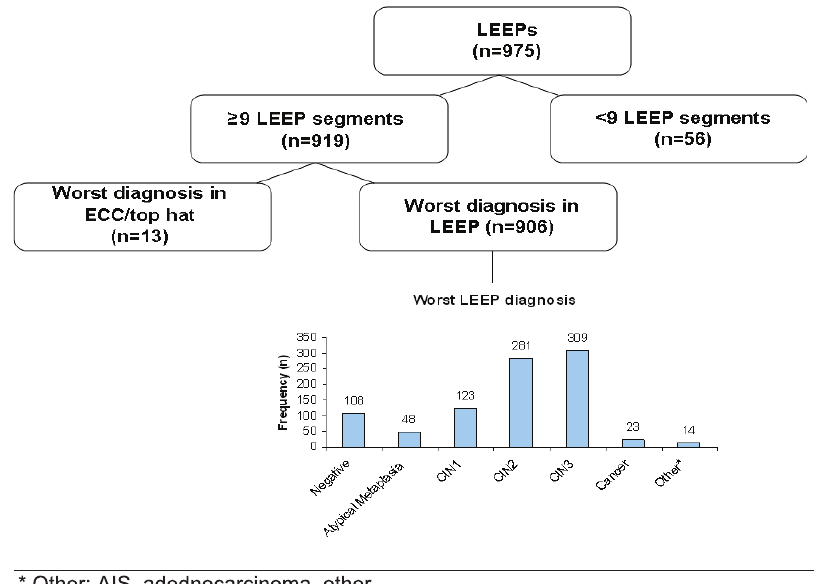
Figure 1. LEEPs performed among SUCCEED women in a colposcopy clinic, 2003–2010.